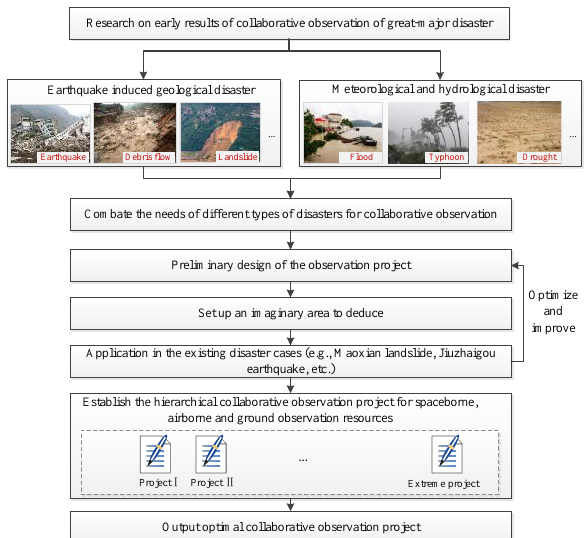
Figure 2. Overall design of collaborative observation project